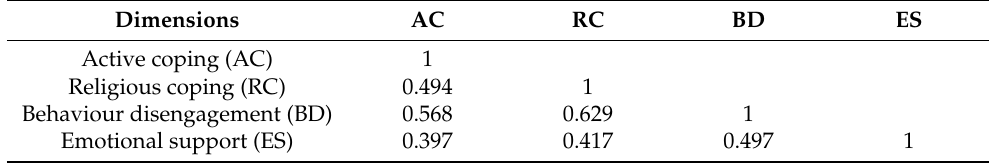
Table 3. Inter-dimension Correlation from the CFA using the DWLS estimation procedure.